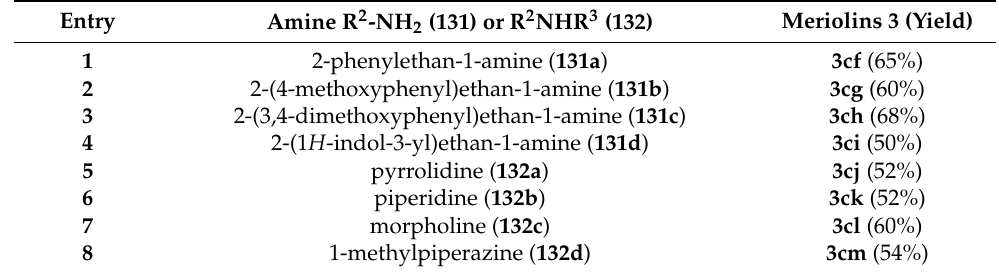
Figure 36. Functionalization of the pyrimidine ring and the N-1 position gave meriolins 3cf - ct [73]. Table 3. Primary 131 and secondary amines 132 used for the functionalization of the pyrimidine ring and the corresponding yields of meriolins 3cf - cm .